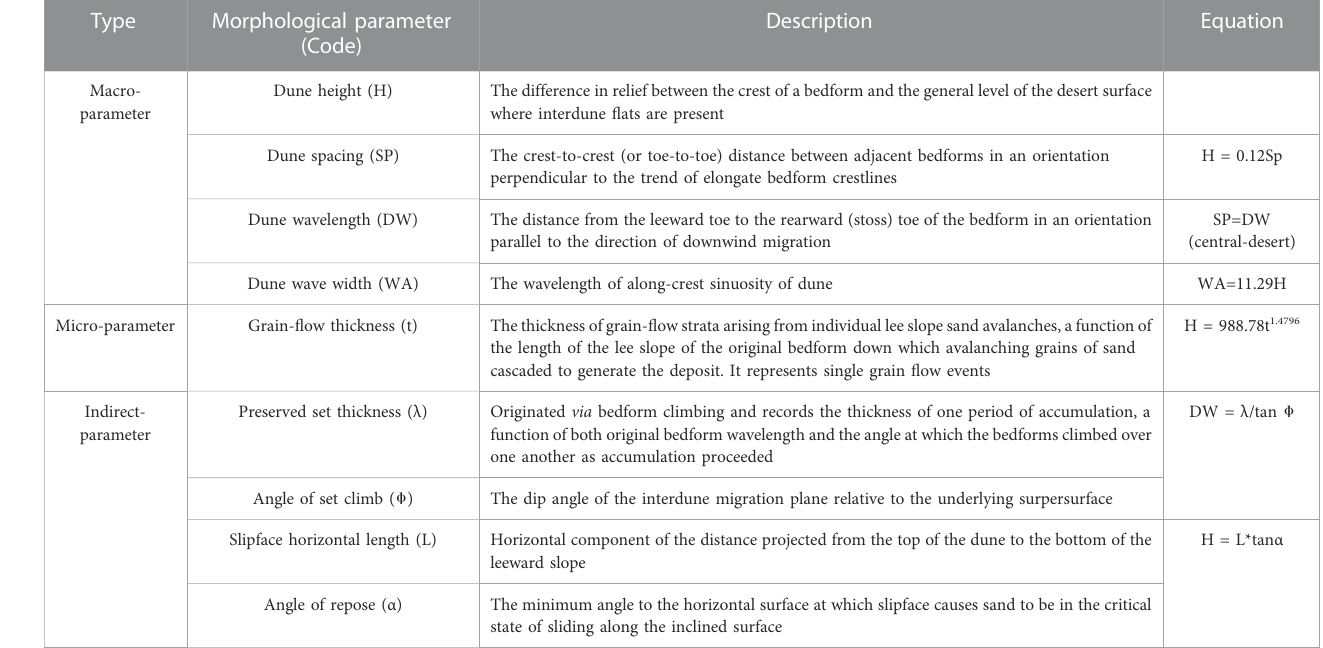
TABLE 1 Summary of morphological parameters of aeolian dunes (Al-Masrahy and Mountney, 2013; Romain and Mountney, 2014).